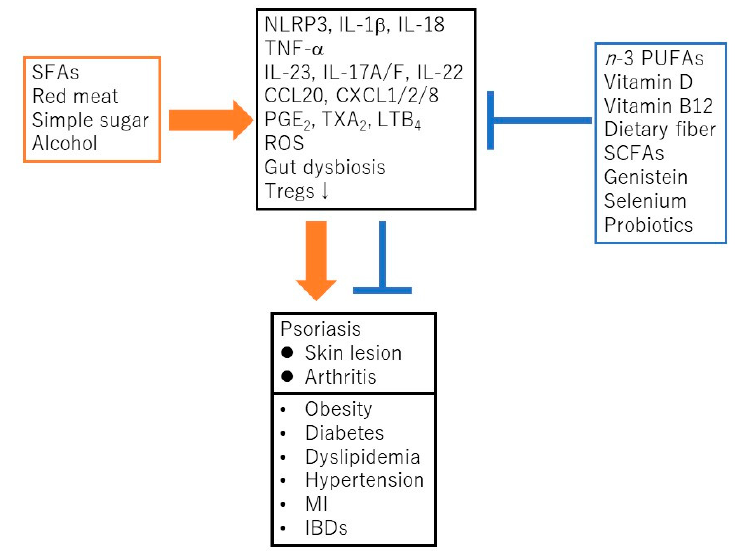
Figure 2. Saturated fatty acids (SFAs), red meat, simple sugars, or alcohol promote the development and progress of psoriasis and its comorbidities via the activation of nucleotide-binding domain, leucine-rich repeats containing family, pyrin domain-containing-3 (NLRP3) inflammasome cascade, TNF- α / IL-23 / IL-17 axis, generation of reactive oxygen species (ROS), prostanoids / leukotrienes, gut dysbiosis, or suppression of regulatory T cells (Tregs). In contrast, n -3 polyunsaturated fatty acids (PUFAs), vitamin D, vitamin B12, dietary fibers, short chain fatty acids (SCFAs), genistein, selenium or probiotics ameliorate psoriasis or its comorbidities via the suppression of above inflammatory signaling pathways or the induction of Tregs. MI, myocardial infarction; IBD, inflammatory bowel disease; PGE 2 , prostaglandin E 2 ; TXA 2 , thromboxane A 2 ; LTB 4 , leukotriene B 4 .